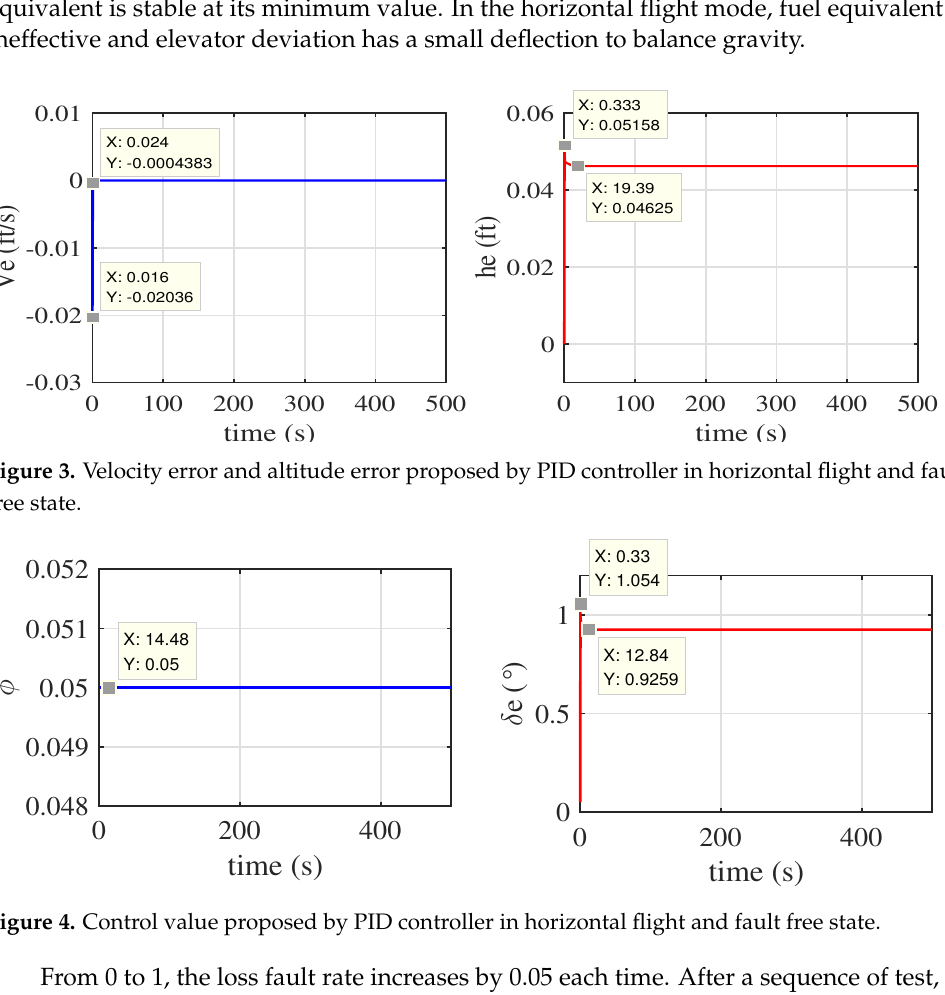
error is almost 0 and the altitude error becomes stable at 0.05 f t . As control value, the fuel equivalent is stable at its minimum value. In the horizontal flight mode, fuel equivalent is ineffective and elevator deviation has a small deflection to balance gravity.